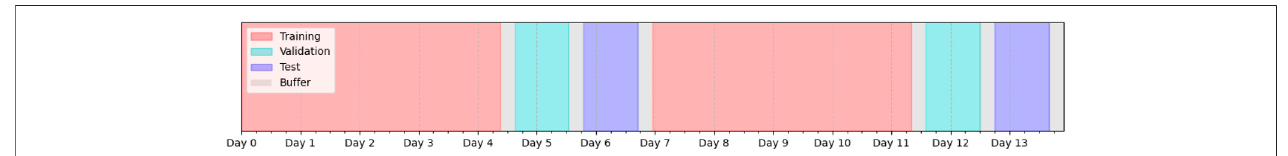
FIGURE 3 | Depiction of time-based splitting of data set into training, validation and test splits. 105 h of continuous data from each week were reserved for the training set, and 22.5 h each for the validation and test sets. A 6 h buffer period between each of the three sets was discarded, ensuring that there was no overlap between the sets.